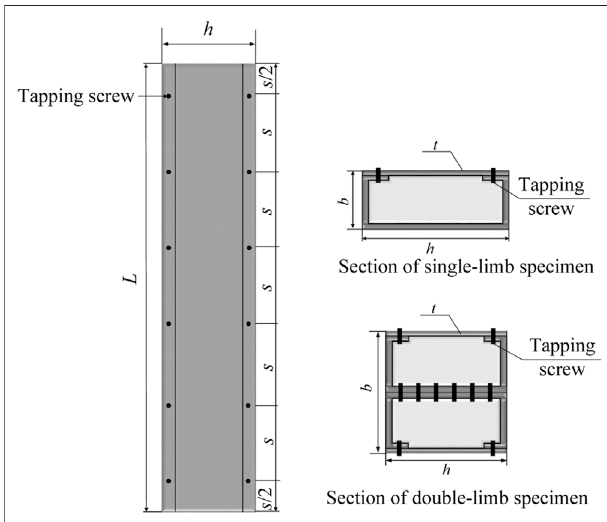
FIGURE 1 | Illustration of specimens dimension.